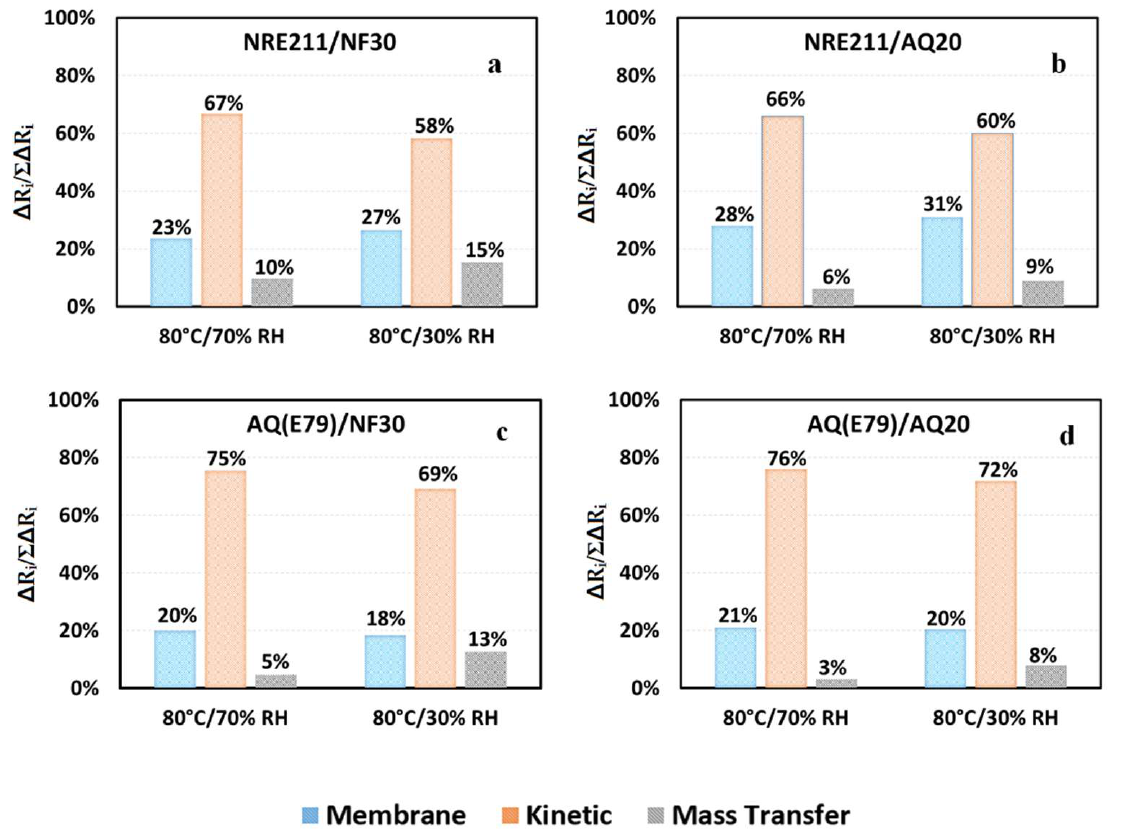
Figure 10. Relative contribution of each resistance to the overall resistance ( ∆ Ri/ Σ∆ Ri) for the selected MEAs ( a ) NRE-211/NF30, ( b ) NRE211/AQ20, ( c ) AQ(E79)/NF30, and ( d ) AQ(E79)/AQ20 at 80 ◦ C under 70% and 30% of RH.